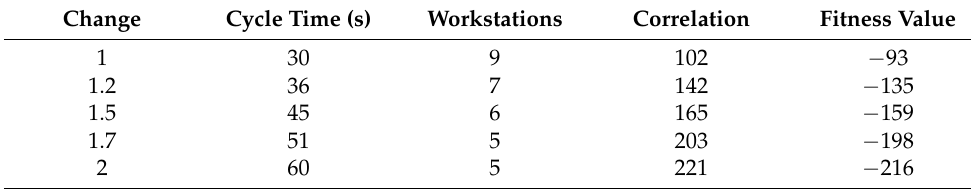
Table 7. Sensitivity analysis considering cycle time